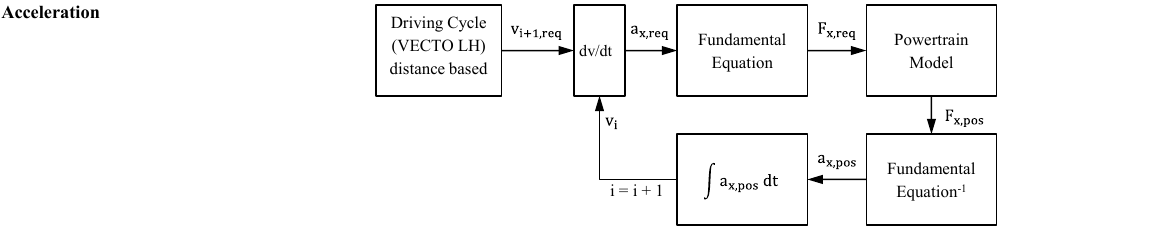
Driving Cycle (VECTO LH)